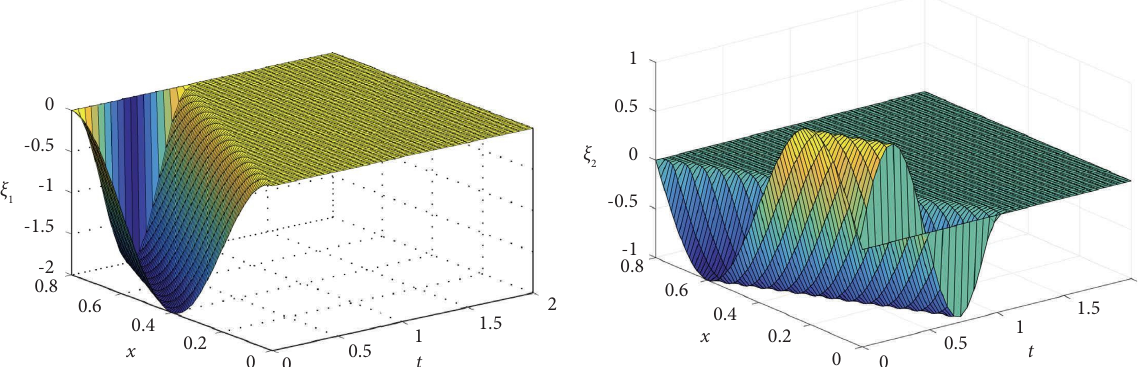
Figure 1: Te convergence of the state ξ